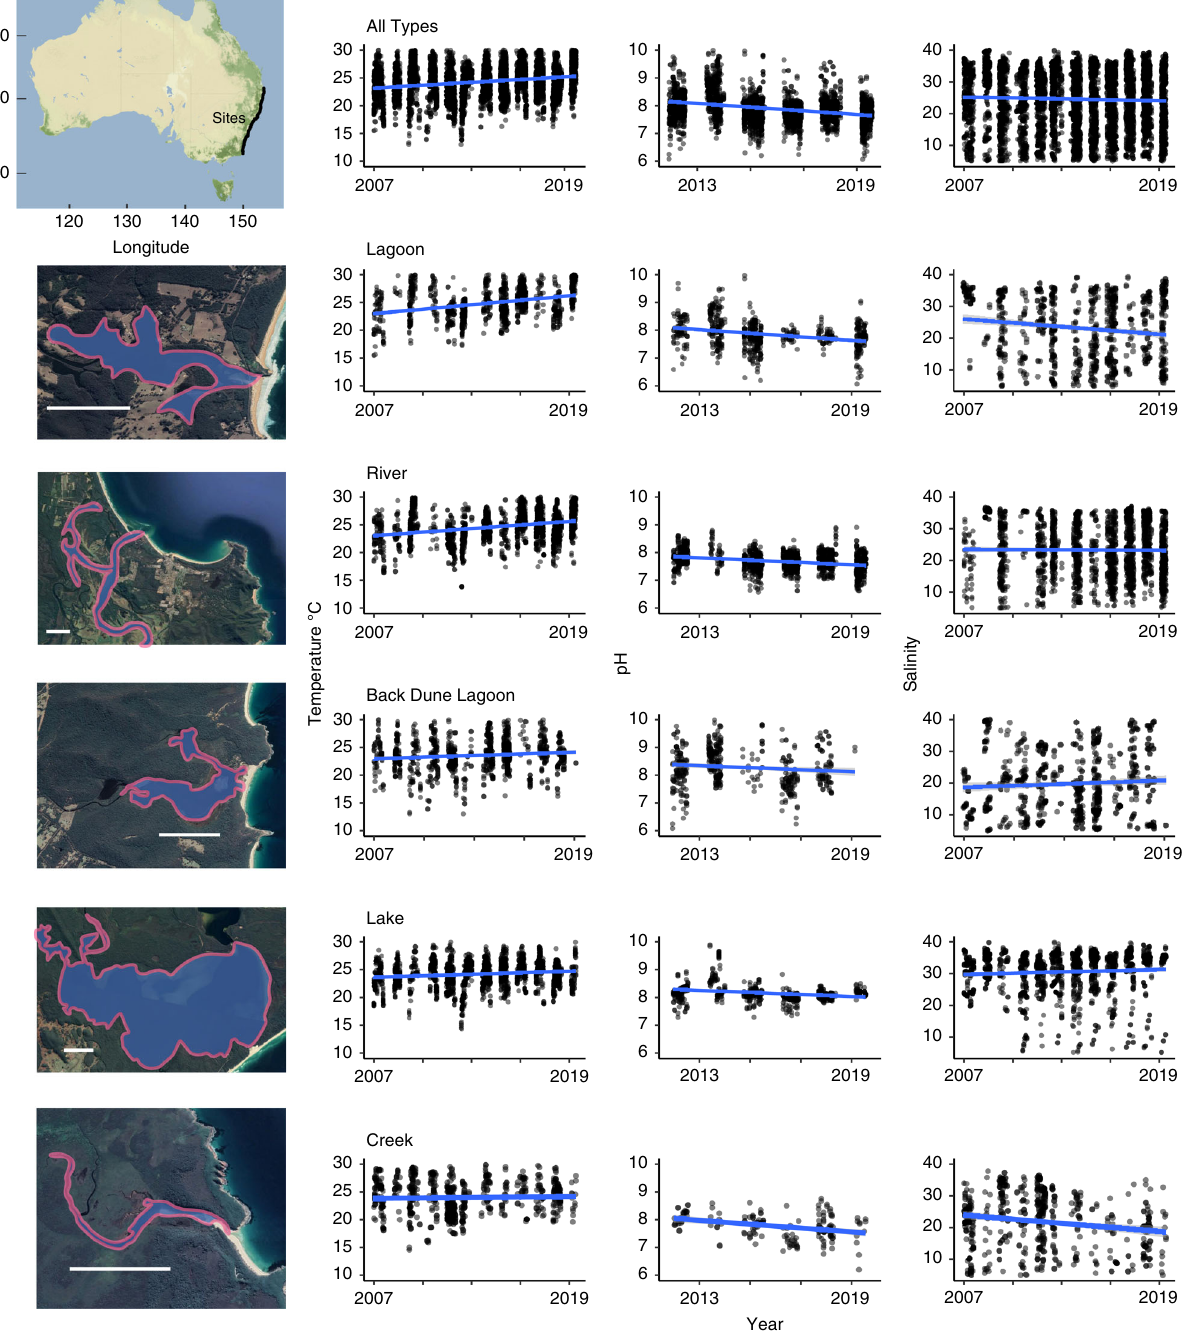
Fig. 1 Observed change in estuary temperature, pH and salinity since 2007. Summer temperature pH and salinity measured over the 12- (temperature and salinity) and 6-year (pH) estuary monitoring programme from December 2007 to January 2019; grey dots indicate each data point, darker dots indicate multiple data on that point. Estuaries are divided into the fi ve estuary types; each estuary is represented by a satellite image of an estuary that is typical of the type, with the body of the estuary outlined in pink. White scale bar indicates 1000 m. Sattelite images of estuaries are sourced from Google Earth (map data: SIO, NOAA, US Navy, NGA and GEBCO). All estuaries are represented on a map of Australia showing the sample sites as black dots.